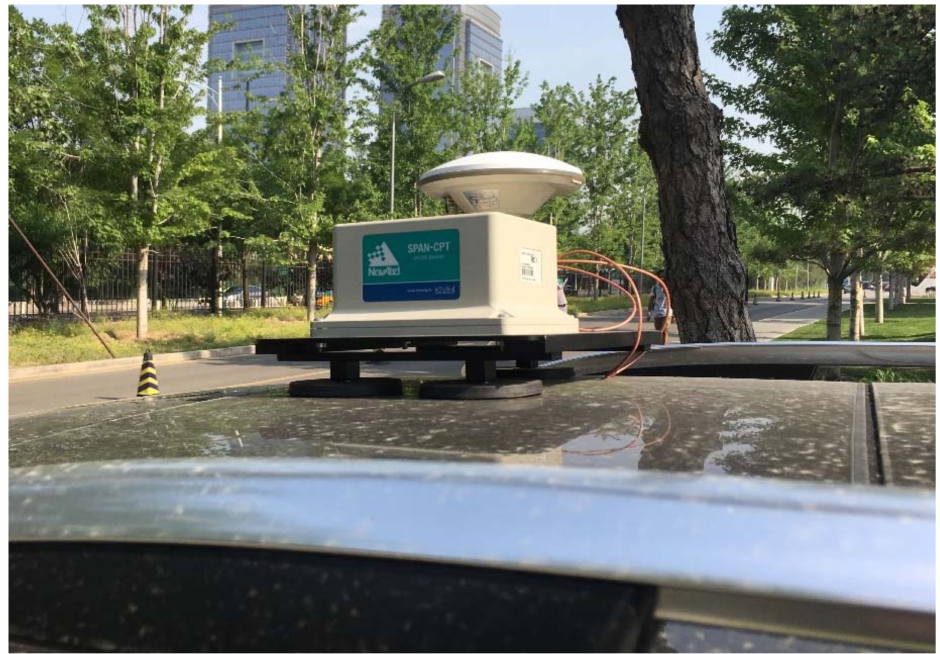
Figure 13. The experimental equipment for data